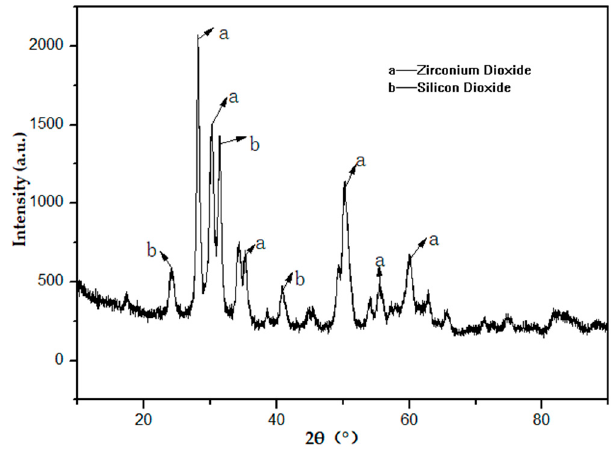
Figure 8. XRD curves of PZAA after ablation at 1000 °C in air.